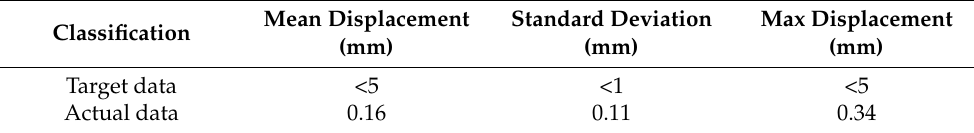
Table 4. Statistical analysis of the load capacity of the snake arms.